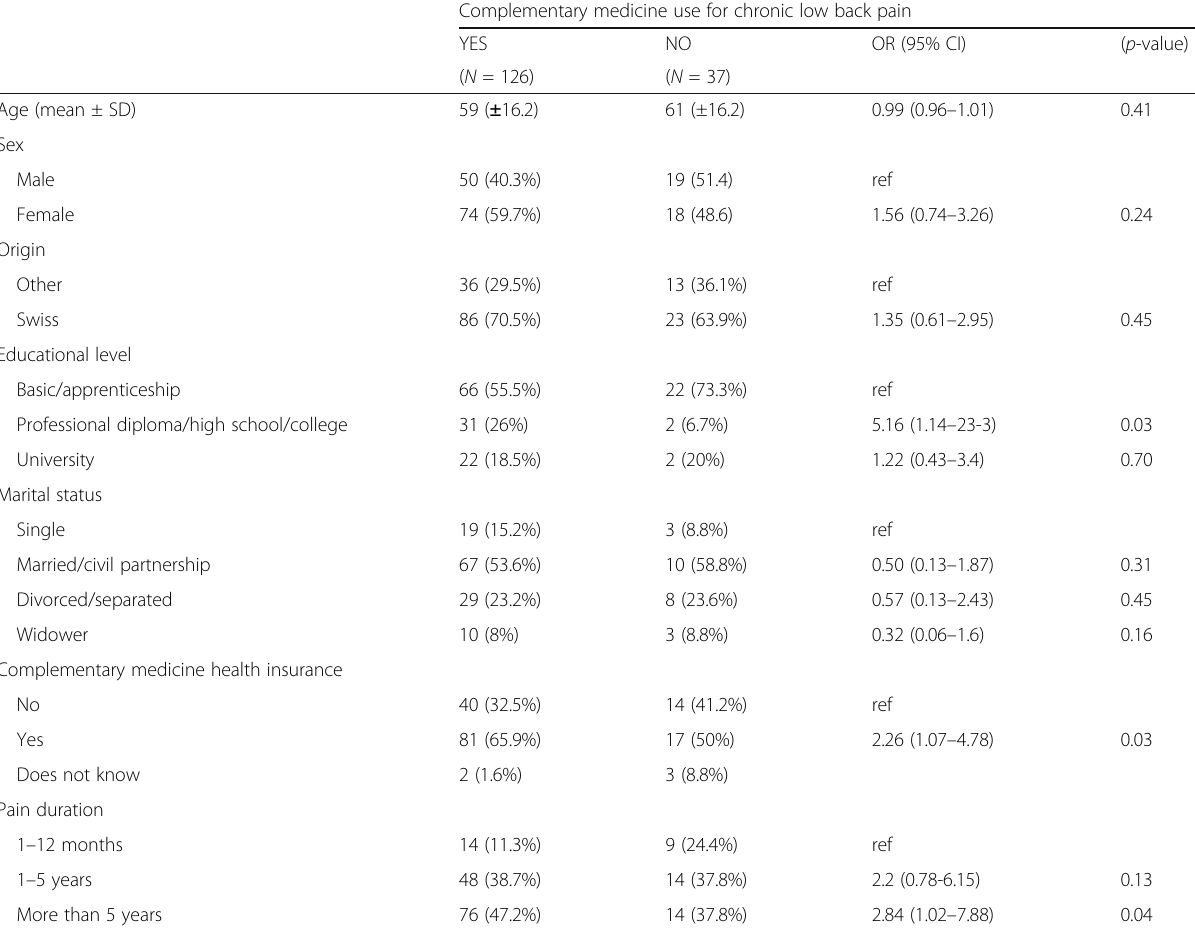
Table 4 Summary data for users (Yes) compared with non-users (No) of complementary medicine for chronic low back